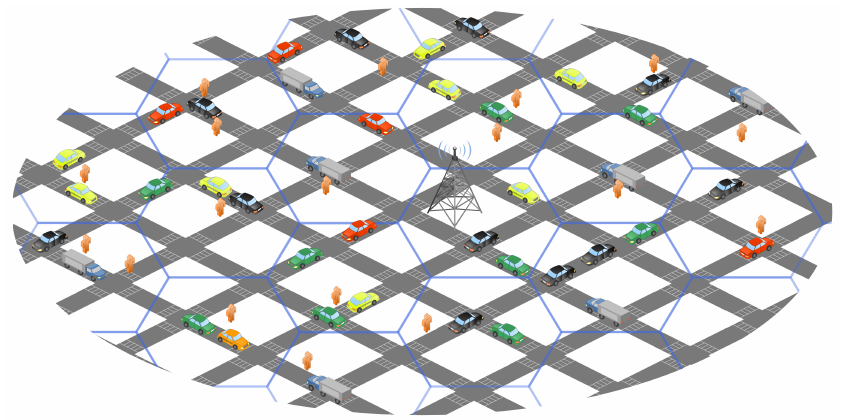
Figure 2. VILE knowledge